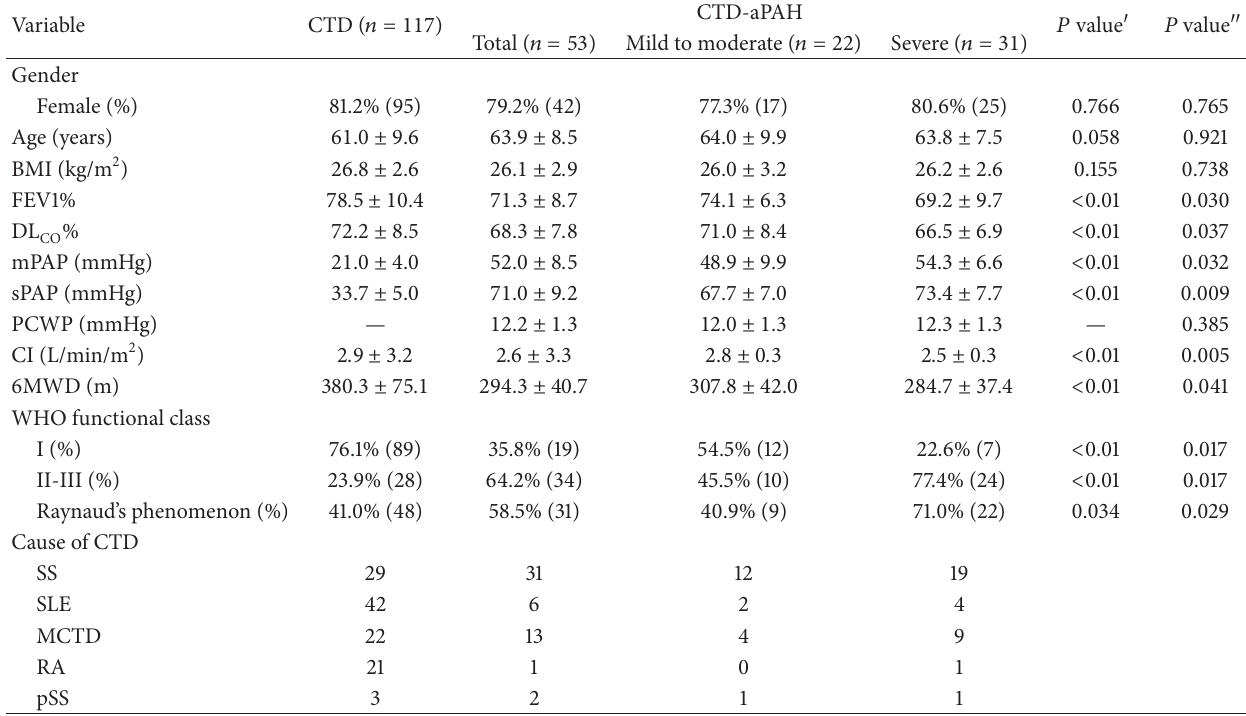
Table 1: Baseline clinical characteristics of study